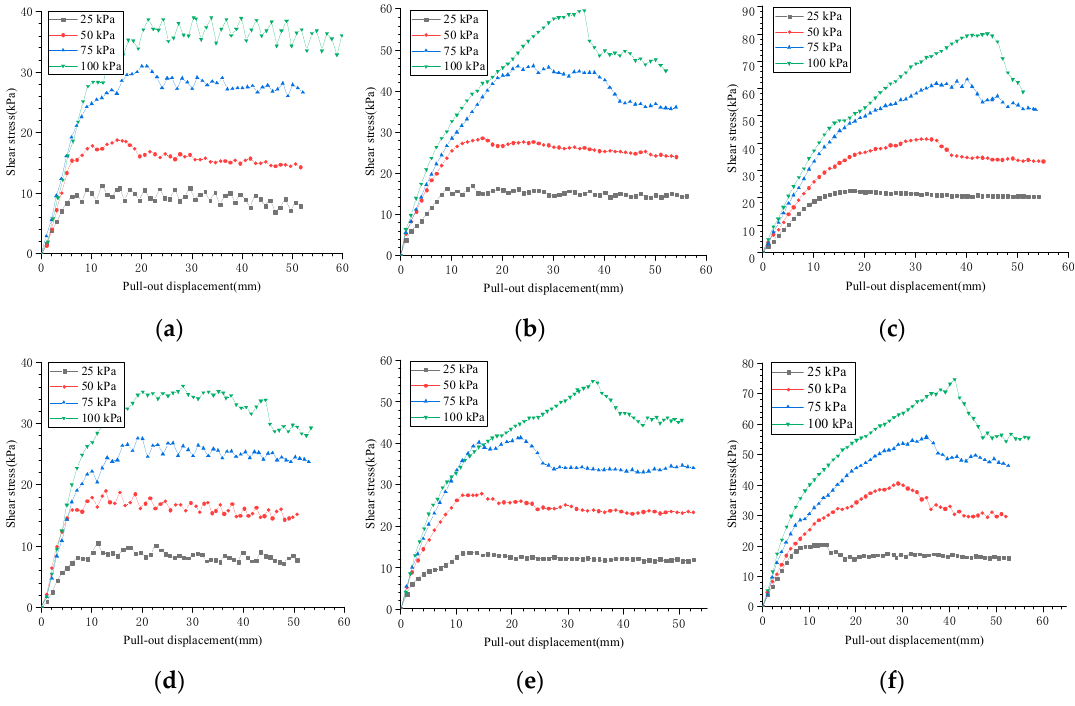
Figure 5. Shear stress and pull-out displacement curves. ( a ) The curves on P-D interface. ( b ) The curves on PTP-D interface. ( c ) The curves on T-D interface. ( d ) The curves on P-W interface. ( e ) The curves on PTP-W interface. ( f ) The curves on T-W interface .